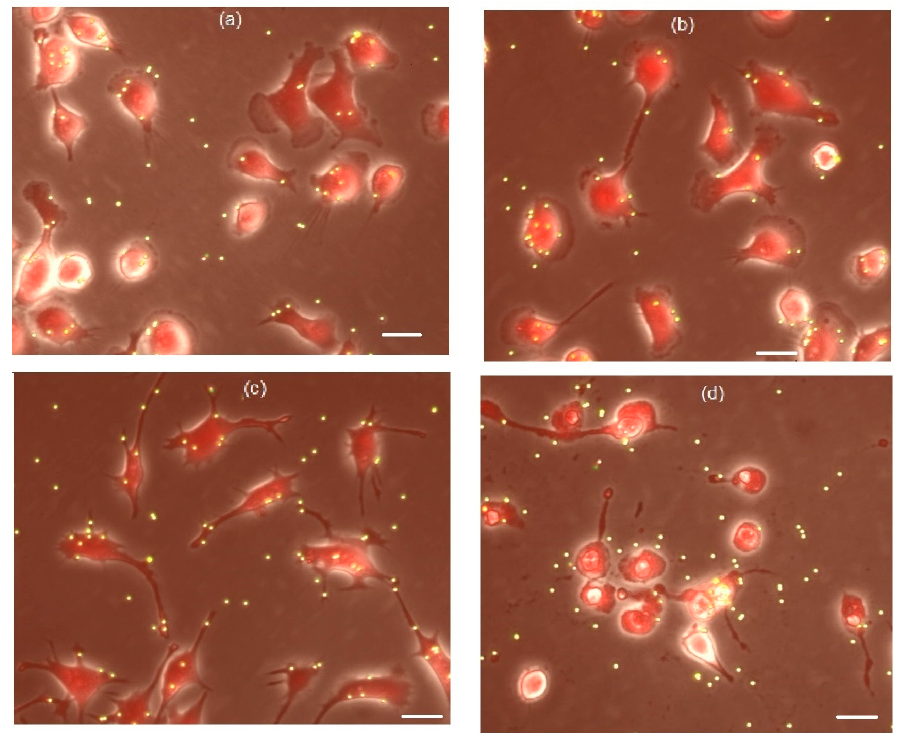
Figure 5. Cholesterol extracting agent m β CD reduces the cytotoxic concentration of peptide P4 for mouse cultured macrophages IC-21. Micrographs of macrophages IC-21 under control conditions ( a ), after 1-h incubation in the presence of 5 µ M peptide P4 ( b ), 5 mM of m β CD ( c ), and in the presence of 5 µ M peptide P4 after 1-h of pre-incubation with 5 mM of m β CD ( d ). After the cholesterol depletion with m β CD, the cells become much more sensitive to peptide P4, which exerts a toxic effect at 5 µ M ( d ). 5 µ M of peptide P4 ( b ) and 5 mM of m β CD ( c ), applied separately, are not toxic . The scale bar in ( a – d ) is 20 µ